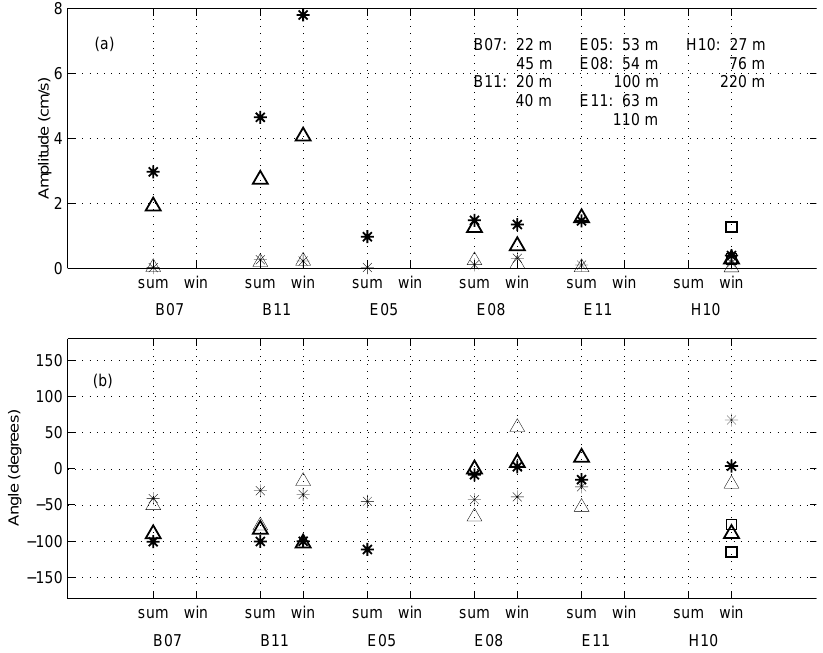
Fig. 3. (a) Semi-major (bold) and semi-minor (light) axis of the M2 tidal component, calculated from current-meter series. Squares indicate the surface current-meters, stars are the intermediate ones, and triangles are the bottom ones. (b) The same as for (a), but for phase (bold) and orientation (light). Angles are given in a trigonometric coordinate system. Current-meter measurement depths are given in the upper right corner of the figure.